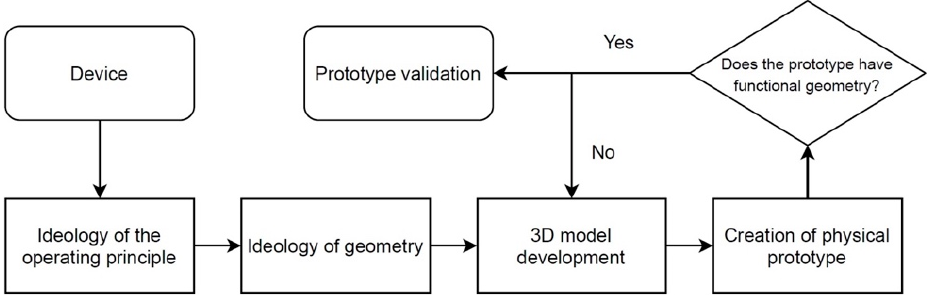
Figure 1. Flowchart of design development.